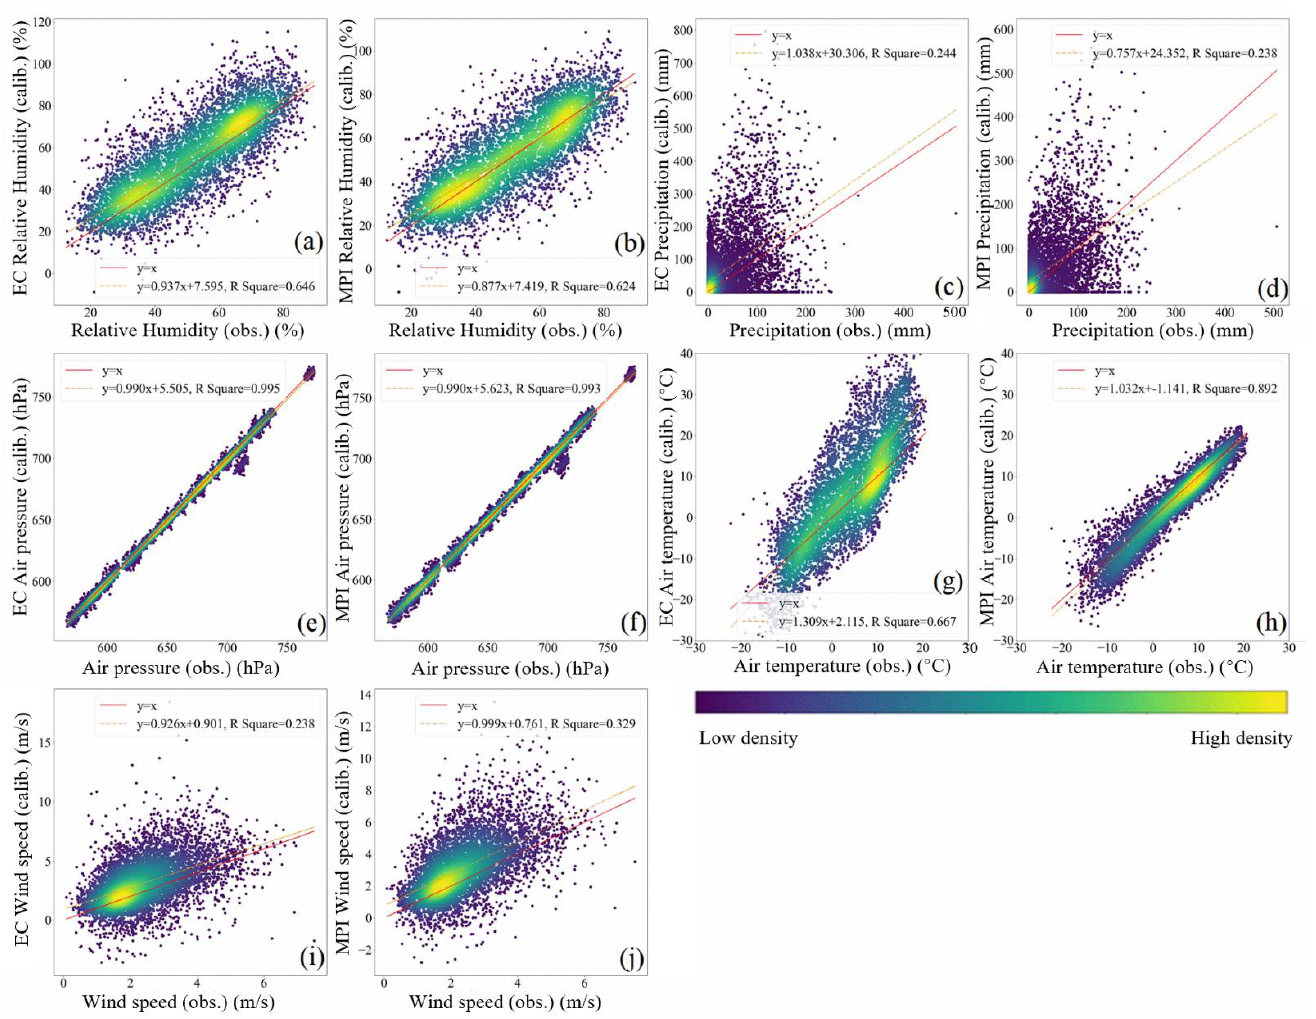
Figure 6. Calibrated results (the ordinates) and corresponding monthly observations (the abscissas) of five major meteorological variables at the 36 QTP sites in the second adjustment (2000 – 2014 as the projection period). The same notations as those applied in Figure 3. ( a , c , e , g , i ) show the results from EC GCM simulations; and ( b , d , f , h , j ) the MPI GCM simulations.